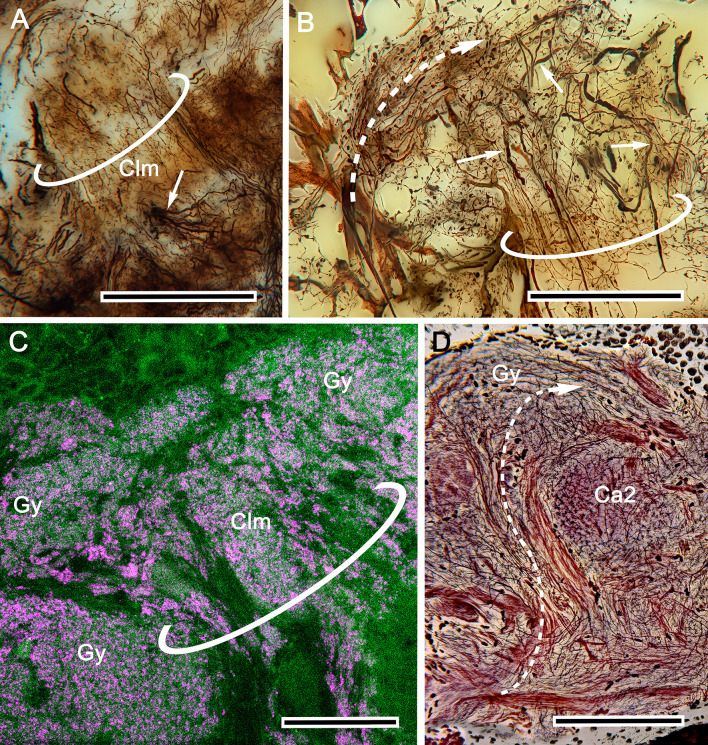
Column-gyrus interface organization.(A) Terminus of column 2 from calyx 2 (Clm, circled). The column is notable for its many extremely slender intrinsic processes. Also, visible in this preparation are branches of extrinsic (efferent) neurons extending across the column (arrow). (B) Terminus of column 2 (circled) with bundled intrinsic processes and the stouter profiles of efferent neurons (arrowed) ascending from the column into overlying gyral neuropil. This superficial level also receives terminals decorated with small bead-like specializations provided by bundled small-diameter axons from the eyestalk nerve (curved arrow). (C) Synapsin (magenta)-actin (green) labeling showing at the terminus of a column (circled) its longitudinal divisions denoted by various sizes and densities of synaptic sites across its width. Similar variation is resolved in flanking neuropil of the gyrus (Gy). (D) Reduced silver demonstrates bundles (dashed arrow) from the caudal lateral protocerebrum ascending outside a column into gyri, demonstrating that multimodal convergence occurs at many levels in the lateral protocerebrum. Part of Ca2 is also visible at this level. Scale bars, A, D, 100 μm; B, 50 μm; C, 25 μm.